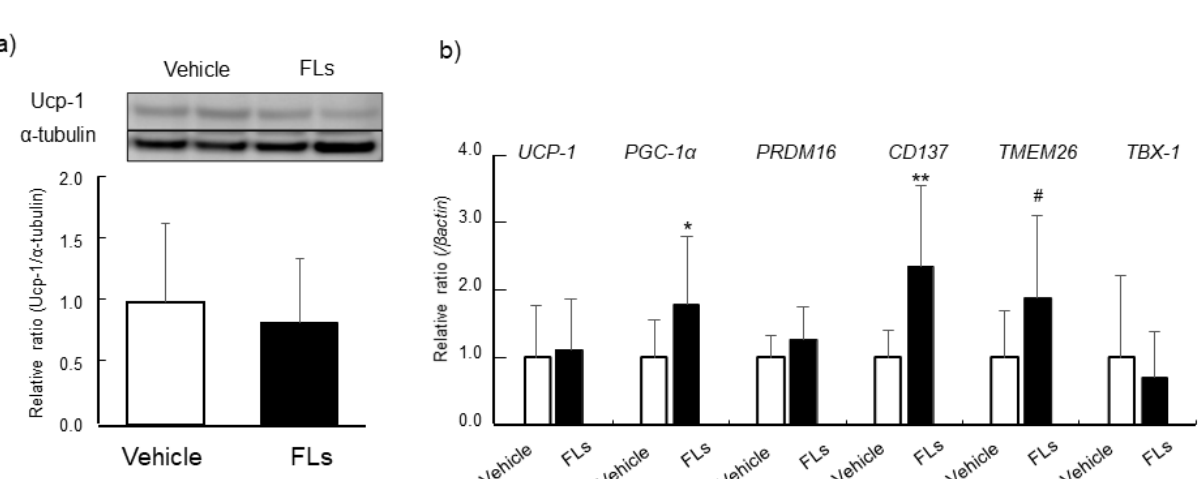
Figure 3. The impact of repeated oral administration of 50 mg/kg flavan-3-ol (FL) s on mice brown adipose tissue (BAT). Ucp-1 levels determined by Western blotting ( a ), mRNA expressions of UCP-1, PGC-1 α and PRDM16 ( b ). The values represent the mean ± standard deviation (each group, n = 11). # p < 0.1, * p < 0.05, ** p < 0.01 (Student’s t-test).